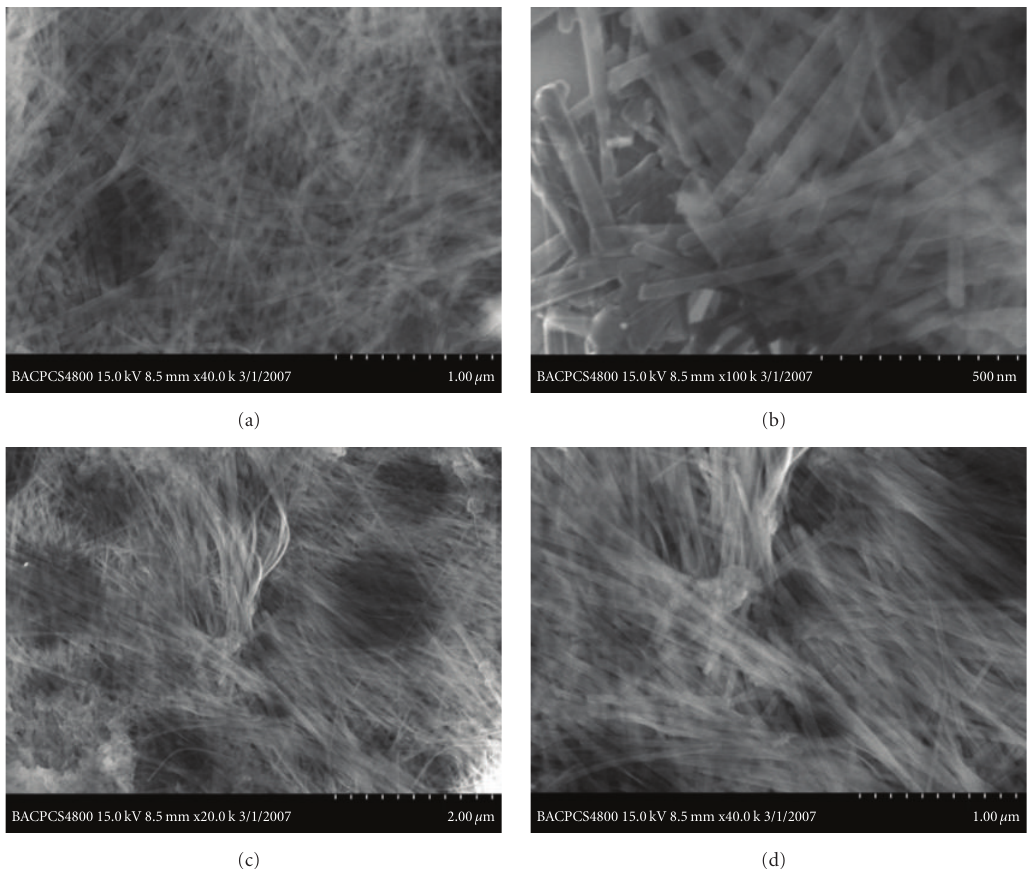
Figure 7: SEM images for Ni/Al LDHs with di ff erent reaction times. (a, b) 12h; (c, d)